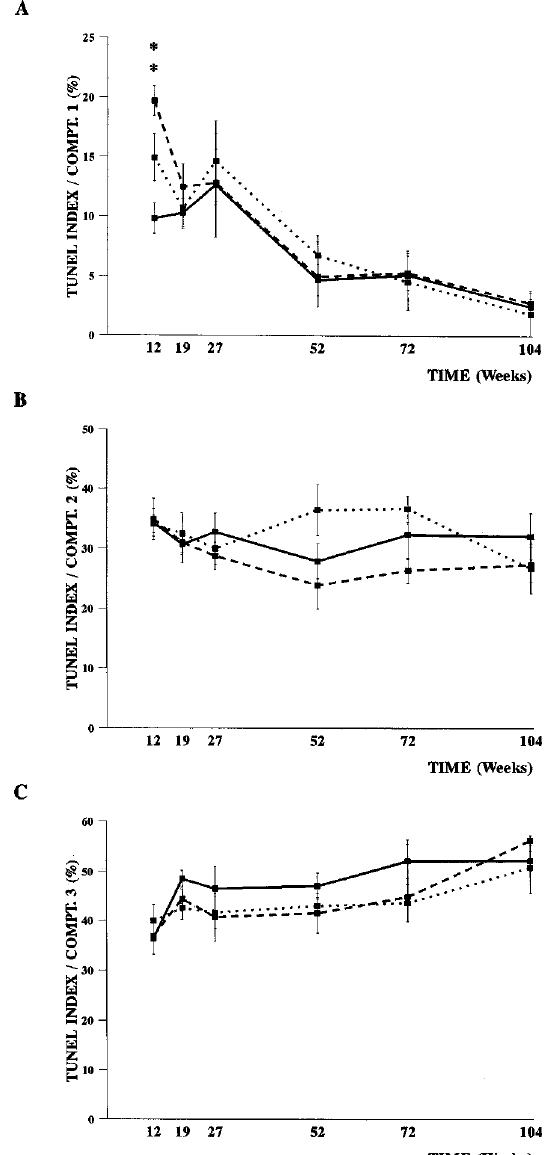
Fig. 2. PCNA LI in compartment 1 (A), compartment 2 (B), and compartment 3 (C). (Control Diet , CD: ___; Western Diet A, WD A: (cid:1)(cid:1)(cid:1) ; Western Diet B, WD B: ----; vertical bars: SEM; * P < 0 : 05.)